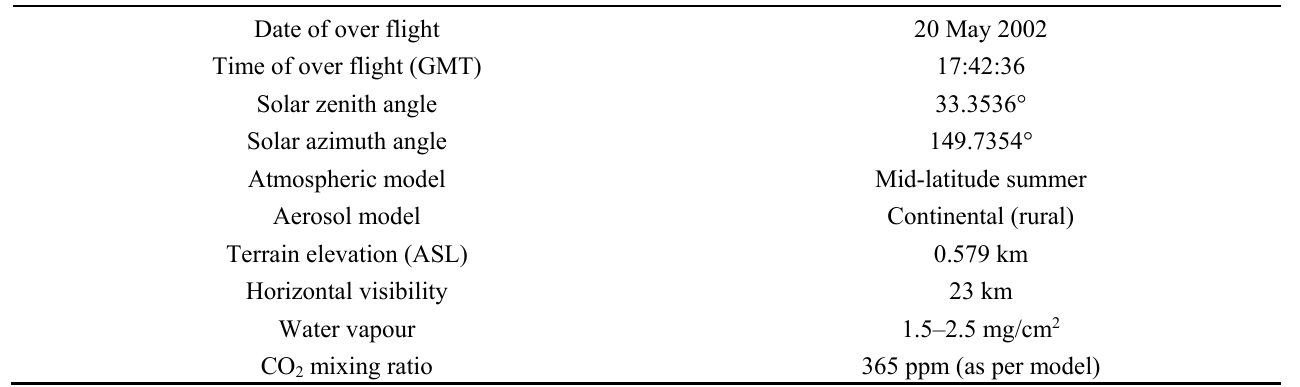
Table 1. Input parameters for the MODTRAN 4.2 radiative transfer